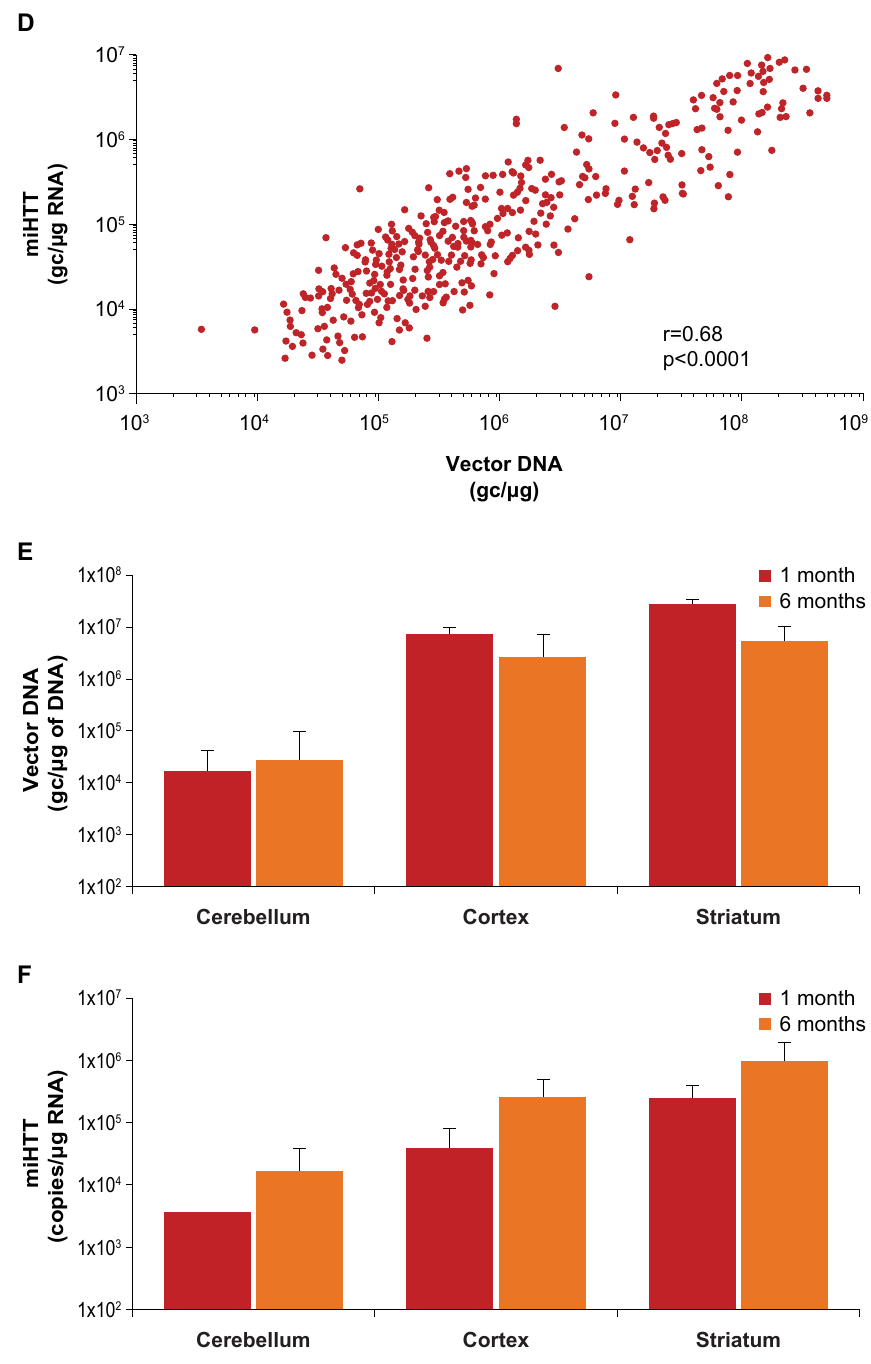
Figure 3. Brain punch analyses. Punches were collected from several brain slices 6 months after injection with AAV5-miHTT and each punch was divided into 3 aliquots to allow different analyses for NHP. For the rats, different brain sections were used for vector DNA and mi HTT analysis. ( A ) An example of a brain map showing where the different punches were taken from brain slice F. ( B ) Vector DNA levels of the brain punches shown as an average (with standard deviation (SD)) of genome copies found per brain region and dose group. ( C ) mi HTT transgene expression of the brain punches shown as an average (with SD) of mi HTT copies per brain region and dose group. ( D ) Correlation between vector DNA and mi HTT transgene expression in NHPs. ( E ) Vector DNA levels in different brain regions of rats shown per dose group and per timepoint as average (with SD). ( F ) mi HTT expression in different brain regions of rats shown per dose group and per timepoint as average (with SD). Only one cerebellum sample was above the lower limit of quantification (LLOQ) for mi HTT (2.5 × 10 3 copies/ µ g of RNA) at 1